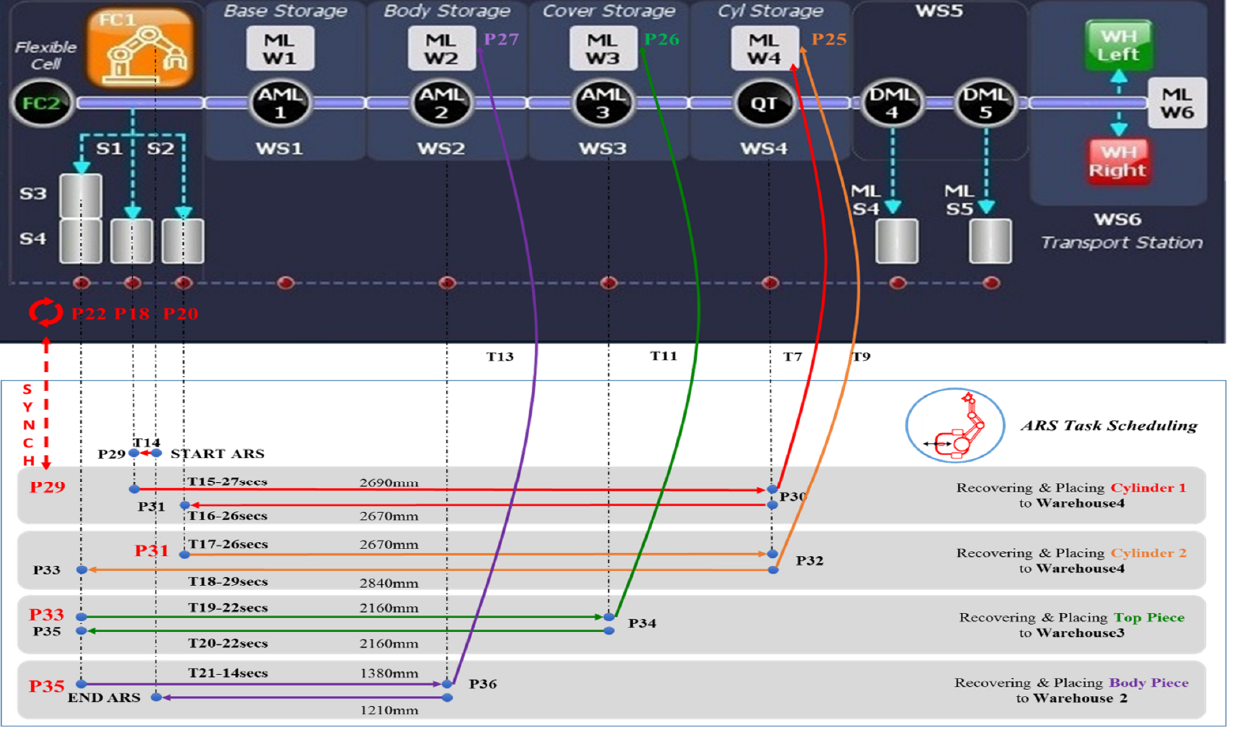
Figure 16. ARS task scheduling for disassembly operation.